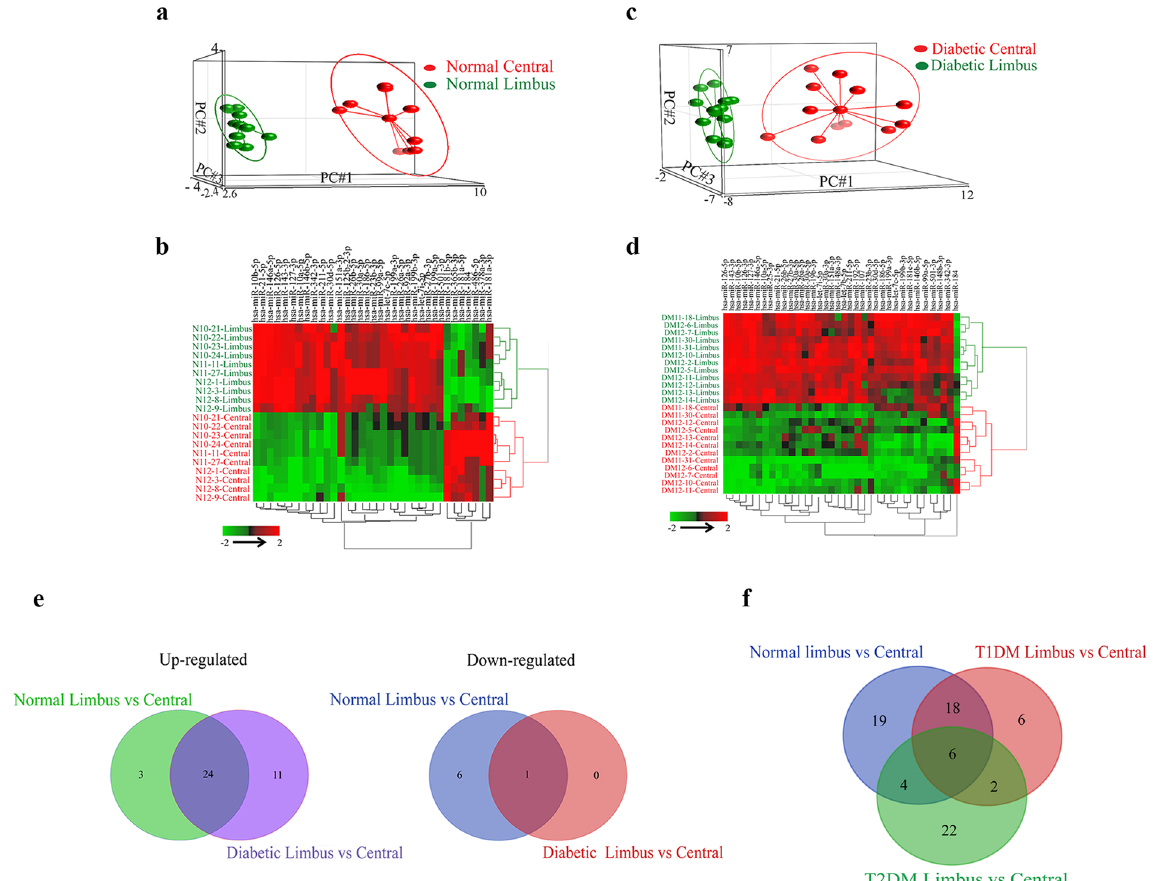
Figure 1. Differentially expressed limbus vs. central miRNAs in normal and diabetic corneas. ( a – d ) PCA and two-way hierarchical clustering plots of limbus vs. central cornea. ( a , b ) 34 differentially expressed miRNAs in normal limbus vs. central cornea. ( c , d ) 36 differentially expressed miRNAs in diabetic limbus vs. central cornea. t-test, FDR adjusted p < 0.05. ( e ) Venn diagrams of up-regulated (left) and down-regulated miRNAs (right) in two-group comparisons of differentially expressed miRNAs (adjusted p < 0.05) in normal and diabetic limbus vs. central corneas. ( f ) Venn diagram of differentially expressed limbus vs. central miRNAs in three-group comparisons in normal, T1DM (IDDM) and T2DM